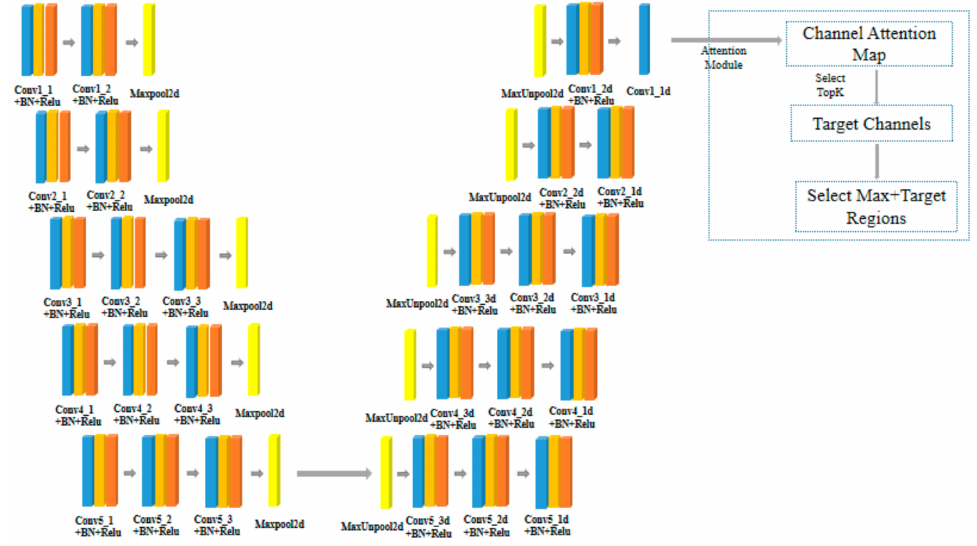
Figure 2. MFTR-Net framework.